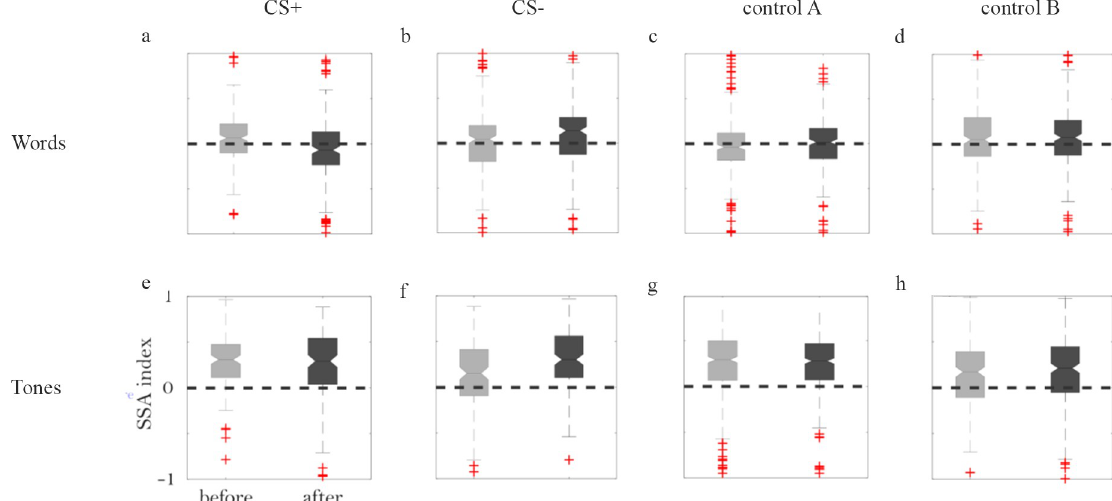
Fig 4. Changes in SSA following conditioning. (a) Box plots showing the distribution of SSA indices before (left, gray) and after (right, black) conditioning, for word-like stimuli used as CS+. The dashed line is at 0, corresponding to equal responses to standards and to deviants. The box is centered on the median of the distribution and its top and bottom edges indicate the 25 th and 75 th percentiles of the distribution. Outliers are marked by red plus signs, and the whiskers show the extent of all the data that is not considered as outliers. The notches represent 5% confidence intervals around the medians. The data on which the boxplots are based include 214 SSA values determined from responses before conditioning and 186 SSA values determined after conditioning, from 10 rats conditioned to word-like stimuli. (b) The same for word-like CS- stimuli (205 values before and 199 after conditioning, 10 rats). (c) The same for the responses to word-like stimuli recorded in animals conditioned with tones (265 values before, 255 after, 6 rats). (d) The same for responses to word-like stimuli recorded in pseudo-conditioned animals (218 values before, 214 after, 5 rats). (e)-(h) The same, for tone stimuli. In this case, control A (panel (g)) consisted of recordings of tone responses in the 10 animals conditioned with word-like stimuli. Number of SSA values (before conditioning, after conditioning, number of rats): (e) (132,132,6); (f) (134, 144, 6); (g) (382, 403, 10); (h) (205, 212, 5). The axes labels and tick labels of panel (e) are common to all panels in this